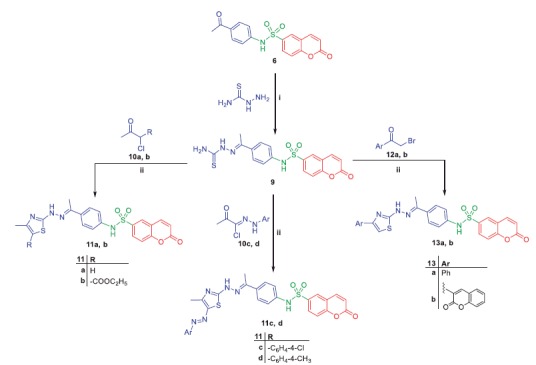
Synthesis of target compounds 11a–d and 13a, b; Reagents and conditions: (i) EtOH/AcOH(catalytic)/reflux 6h (ii) Dioxane/TEA (catalytic)/reflux 8h.